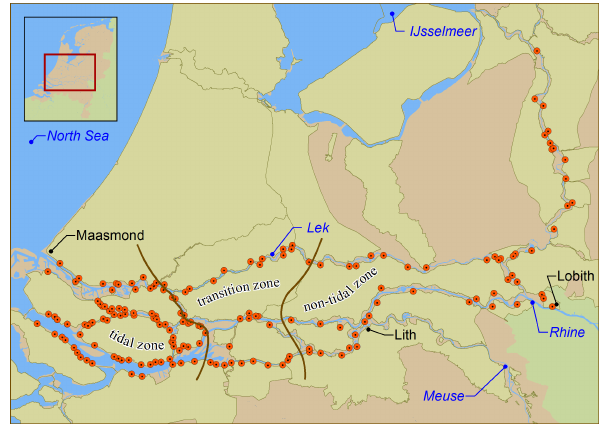
(along the Rhine at the German–Dutch boundary), Lith (along the Meuse), Maasmond and the IJssel lake and the surrounding flood-prone areas (see Fig. 2).